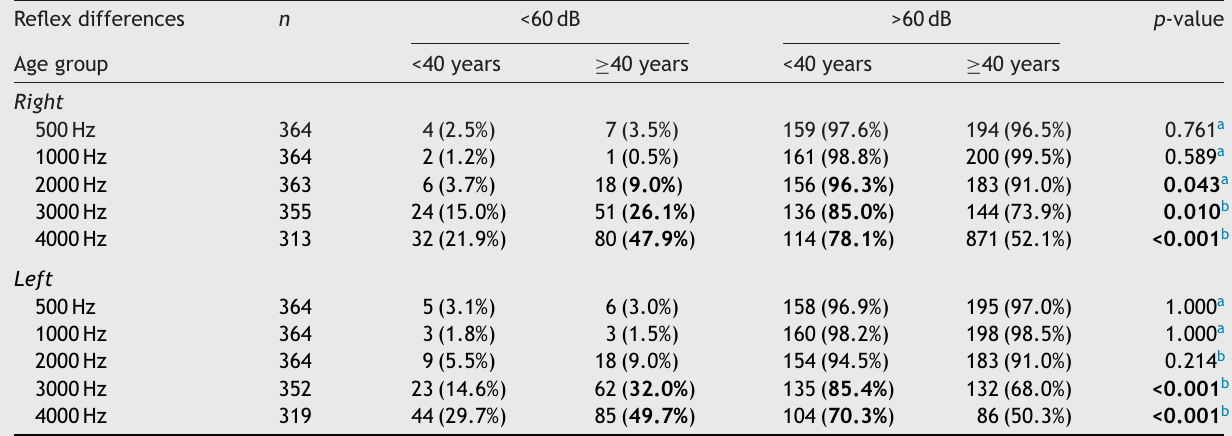
Comparison between age group of workers and occurrence of Metz recruitment.